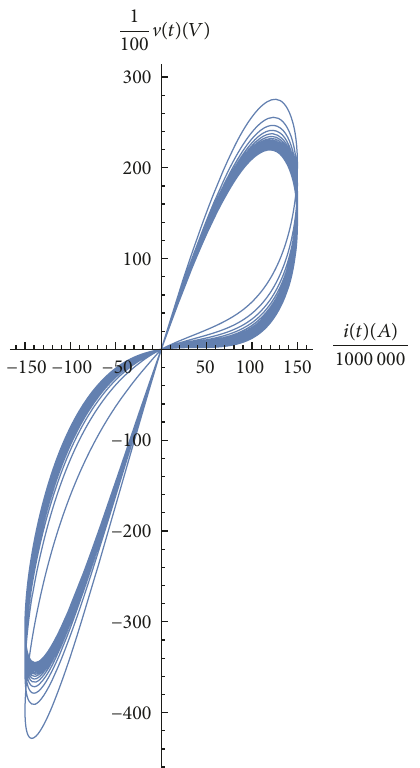
Figure 11: V (𝑡) - 𝑖(𝑡) of the fractional order memristor: 𝛼 = 0.75 and 𝐼 < 𝑚